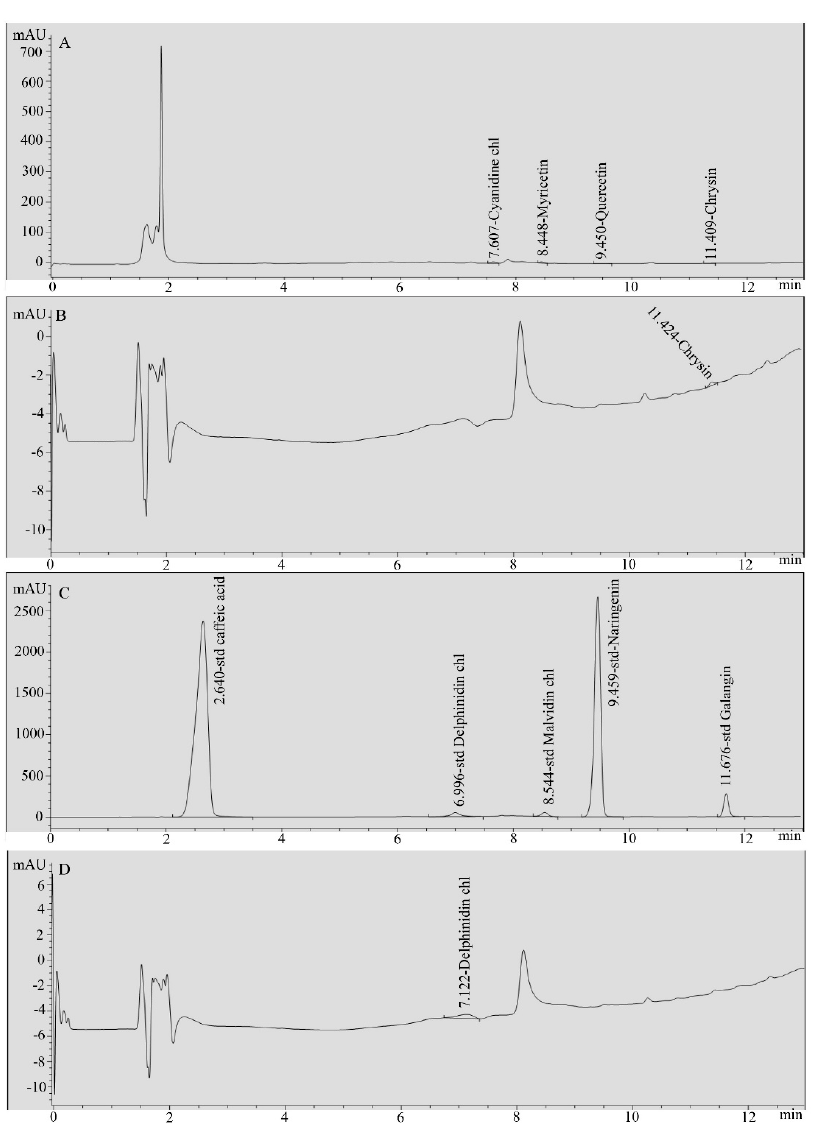
Figure 1. HPLC chromatograms of ginger water and reference standards. ( a ) Standard mix1, ( b ) ginger water, ( c ) standard mix2, and ( d ) ginger water.